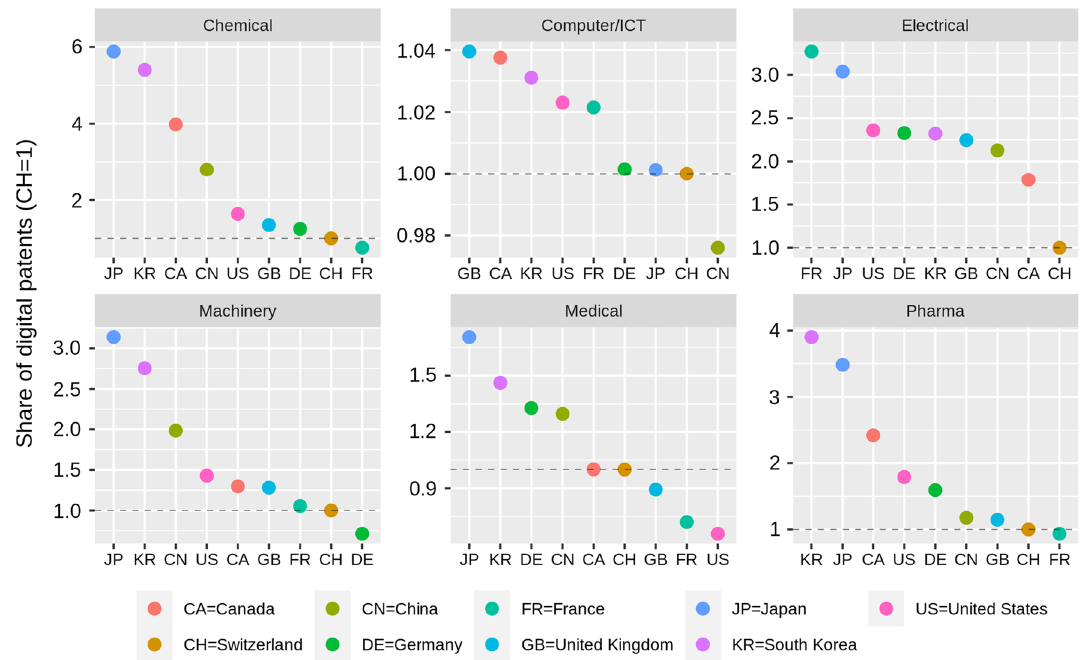
Fig. 3 Share of digital patents of different industries and countries. Notes : Calculations based on the definition for digital IPC classes from Inaba and Squicciarini (2017) that were matched to USPTO patents between 2010 and 2015. The figure shows the number of digital patents of industry j of country c relative to the total number of patents of industry j of country c , normalized by the value of the respective Swiss industry: ( num_digital_pat j , c / num_pat j , c